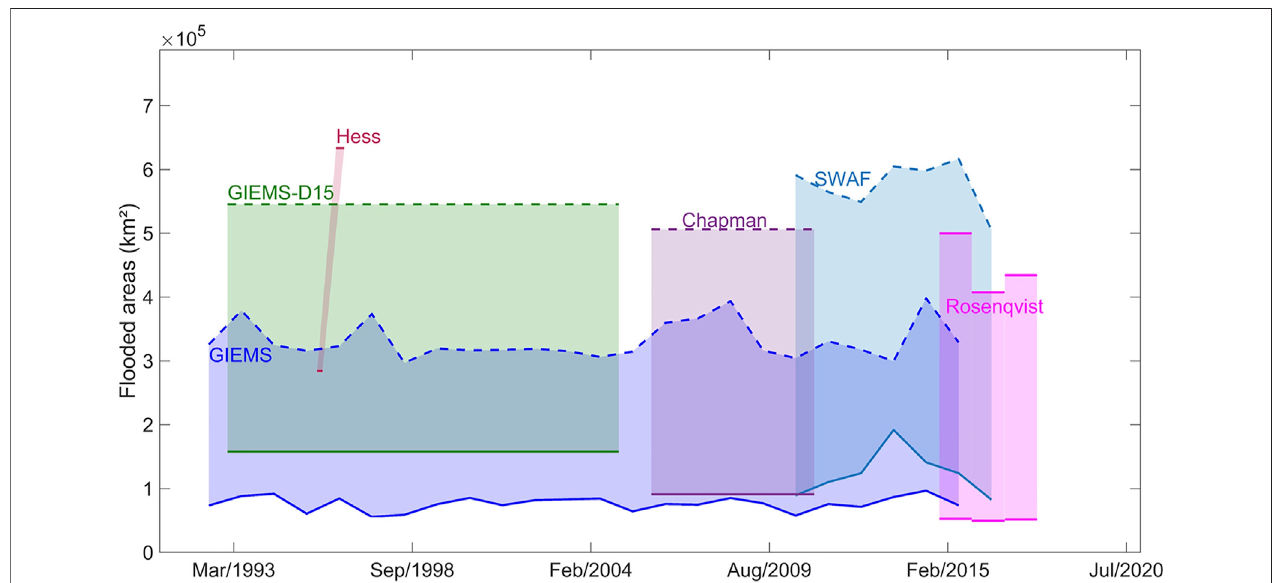
FIGURE 1 | Maximum and minimum inundated areas for Amazon basin < 500 m asl based on different remote sensing and analysis techniques. GIEMS: Prigent etal.(2020),GIEMS-D15:Fluet-Chouinardetal.(2015),Chapman:Chapmanetal.(2015),SWAF:Parrensetal.(2019),Rosenqvist:Rosenqvistetal.(2020),Hess:Hess et al. (2015).